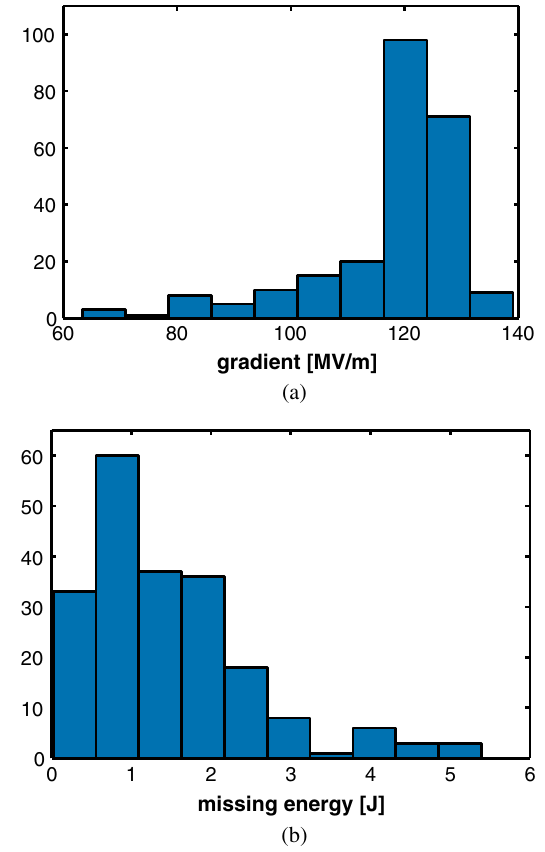
FIG. 7. Distribution of (a) accelerating gradient and (b) missing energy for the 246 breakdown events considered in our